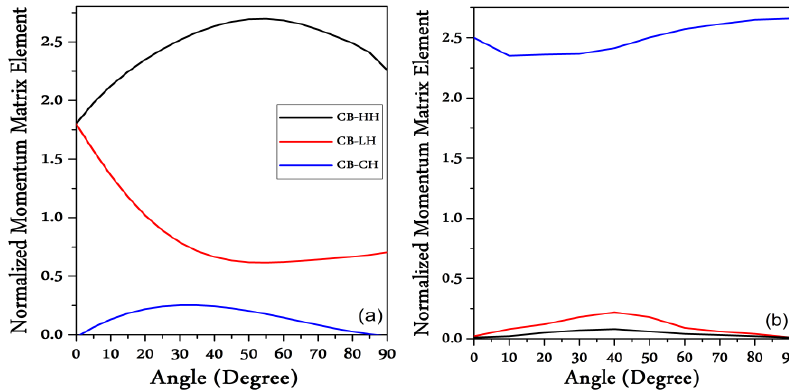
Figure 8. In 0.17 Ga 0.83 N / GaN QW blue laser’s optical momentum matrix elements normalized at Γ -point as a function of inclination angle θ for carrier transition from CB to HH, LH and CH due to ( a ) transverse electric (TE) and ( b ) transverse magnetic (TM) polarization.